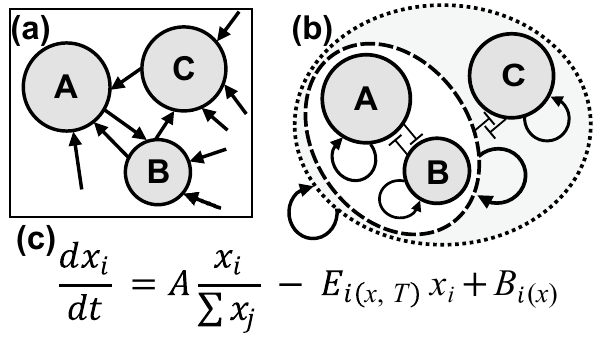
Figure 6. The law of biological inertia. ( a ) A conventional model of expression regulation of genes A, B and C. Each gene is regulated by others. The networks become complicated as the number of genes increases. ( b ) In the learning hierarchical-pair model, each gene or gene-cluster changes the expression level by amplification and decay, which are represented by self-regulation. Competition in each pair is presented as mutual inhibition. Two components in each dotted oval indicates a pair in a hierarchical architecture. The process in each pair proceeds in parallel. ( c ) The equation represents the law of biological inertia, which means that a living cell basically keeps the expression pattern while renewing the contents. The equation indicates that the i th gene transcription level changes by competitive amplification, error-dependent decay, and additive increase. In Fig. 1 in the range Σ x j >> Σ β j , x i ∈ { x A , x B }, A = α inc (1 − γ ), E i ( x , T ) = α dec ε (x) , and B i(x) = γα inc β i / Σ( x j + β j ). The openness degree of chromatin at the i th gene locus,